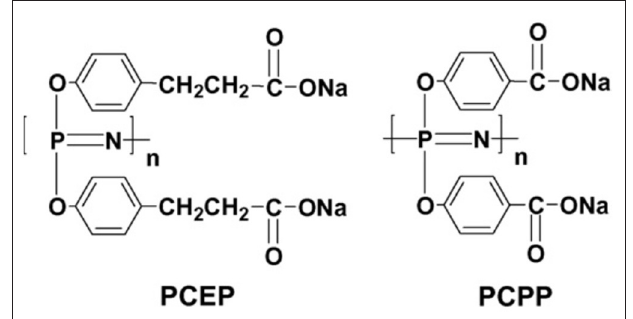
FIGURE 1 | Chemical structures of the polyphosphazene polymers PCEP and PCPP (reprinted from Mutwiri et al., 2007, copyright 2007, with permission from Elsevier)